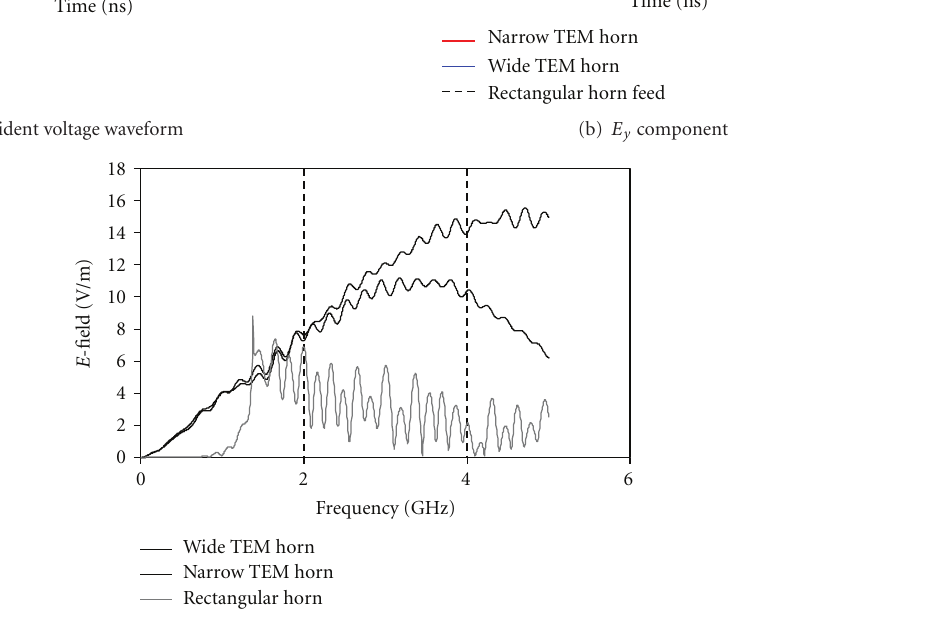
(c) Fourier transform of E y components Figure 13: Calculated E-field obtained from a commercial simulator at a distance of 10 m from the center of the parabolic antenna. The incident voltage peak is 7.07